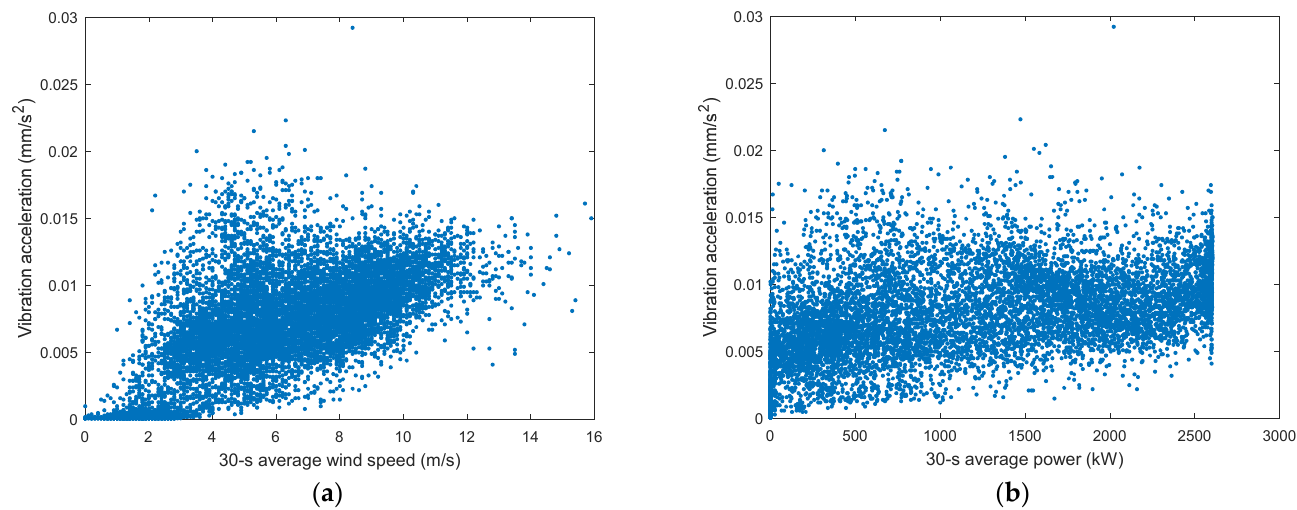
Figure 1. Variations in spindle vibrational acceleration with ( a ) 30-s average wind speed and ( b ) 30-s average power.